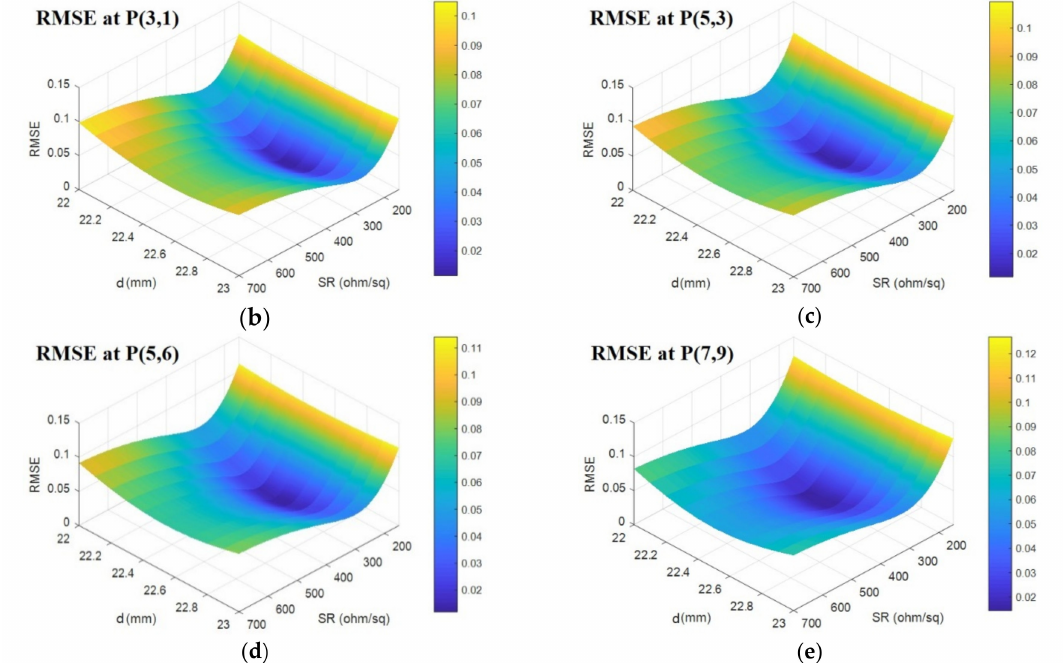
Figure 9. Surface resistance prediction results based on an evaluation of the root mean square error (RMSE) with calculations and measurements of reflectivity: ( a ) surface resistance distribution for a high RS on the absorber, ( b ) RMSE at P(3,1), ( c ) RMSE at P(5,3), ( d ) RMSE at P(5,6), and ( e ) RMSE at